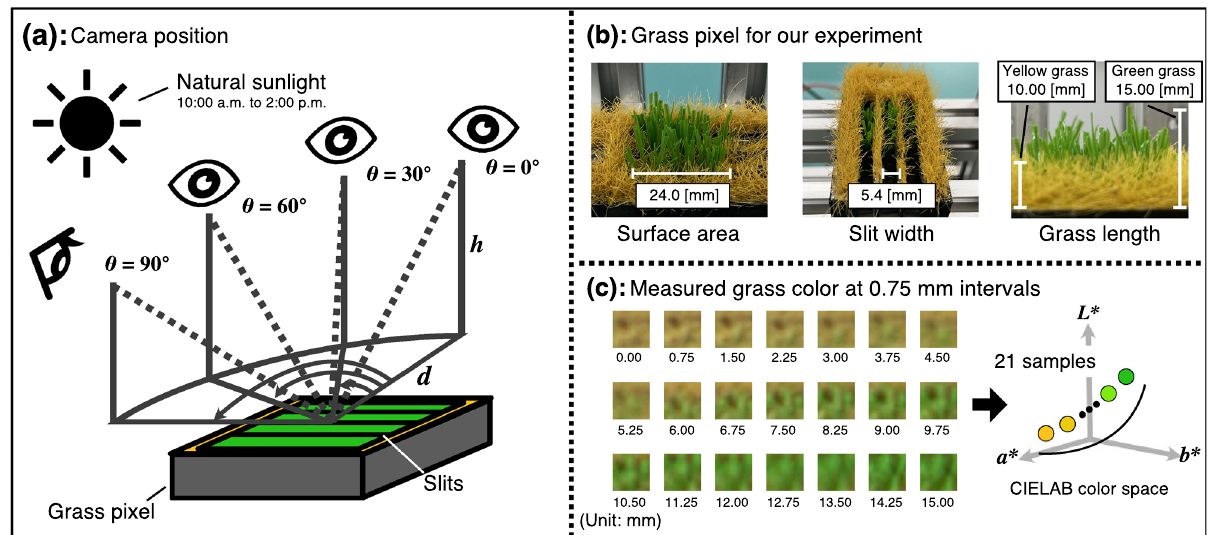
Figure 5. Experimental environment of grass color scale setting procedure. ( a ) A digital camera was located at multiple positions based on the viewer’s height, a distance and a horizontal angle between a viewer and a grass pixel. ( b ) The grass pixel was developed for our experiment of the grass gradation scale setting procedure. ( c ) The grass color of the grass pixel was measured as a CIELAB value at 0.75 mm intervals. This figure was created using Serif Affinity Designer version 1.10.0 (https:// affin ity. serif. com/ en- us/).